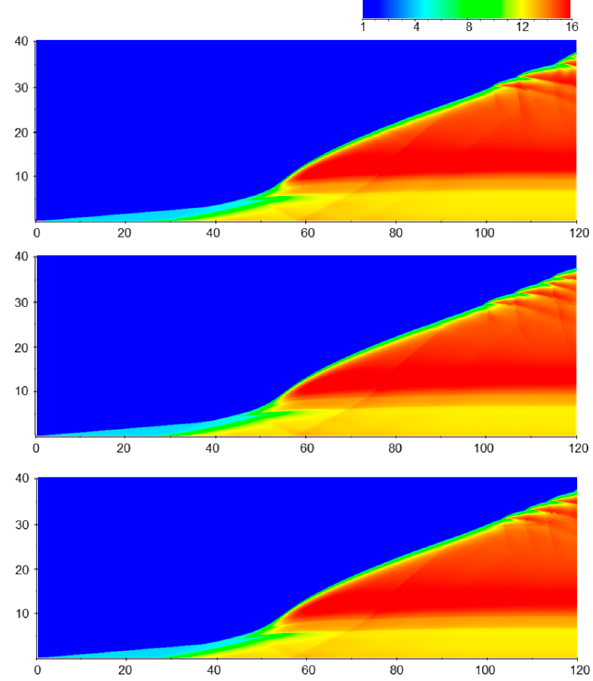
Figure 3. Temperature contours with 32 (upper), 64 (middle) and 128 (lower) pts/ ∆ I for M 0 = 10.0, θ = 30° and k R = 2.8 for the two-step induction-reaction kinetics.